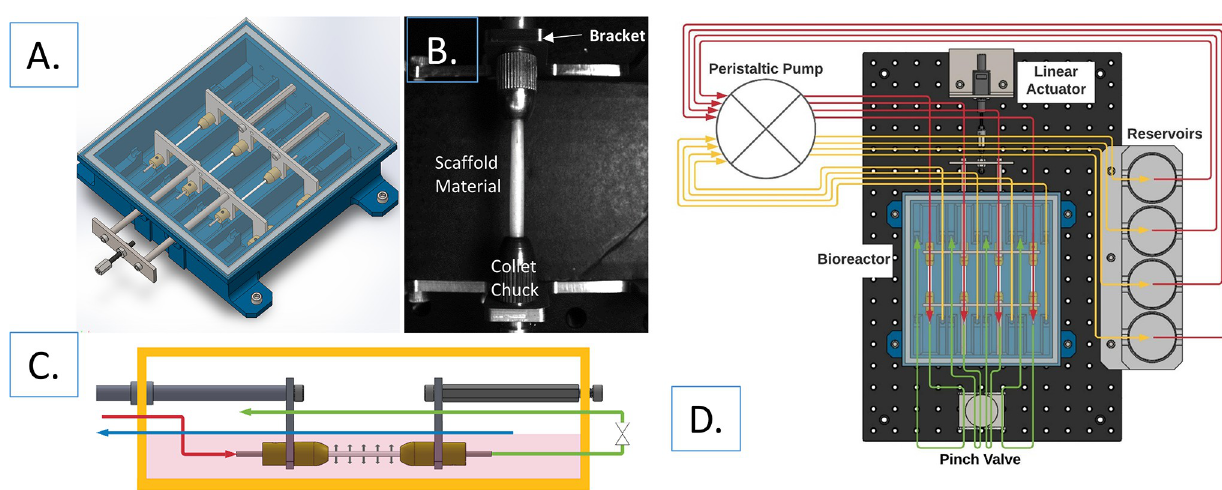
Fig 1. Bioreactor design. (A) The fully assembled bioreactor chamber. Intake and outtake tube holders are found on each side of the individual ETVG chambers. (B) An electrospun PCL tubular scaffold mounted with collet chucks in a four-pronged stainless-steel bracket. The 2mm cannulas affixed to either end of the scaffold form a tight seal with the tightened collet chucks. This connection makes tensile stretch and luminal pressurization possible while also leaving the lumen of the ETVG in direct contact with media flow. (C) Flow diagram within the bioreactor chamber. The red arrow shows media traveling from a reservoir to the ETVG lumen, the green arrow shows media movement out of the ETVG, out of the bioreactor, through the pinch valve, and back into the bioreactor. The blue arrow represents media being drawn from the bioreactor chamber to return to the reservoir. (D) Full schematic of bioreactor flow loop and intended features. Color coded as in panel C.